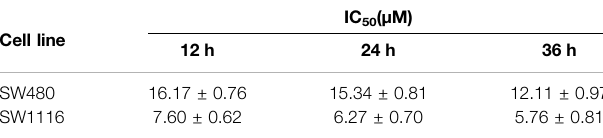
TABLE 1 | Inhibitory concentration (IC 50 ) of IVM on the viability of colorectal cells.